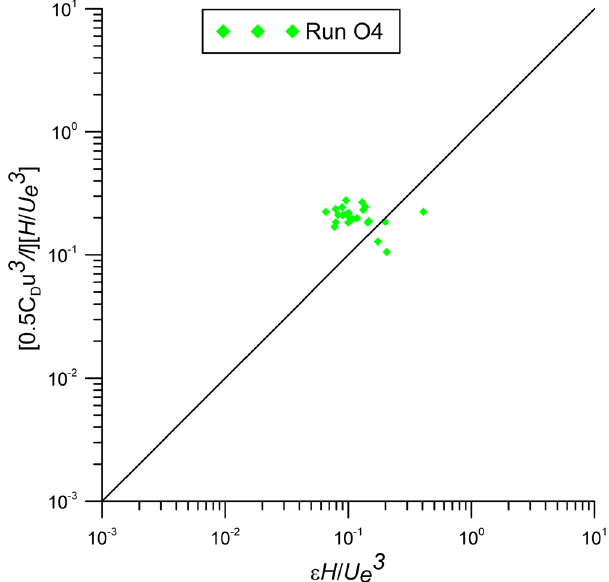
Figure 12. Estimates of dissipation rate of the cross section at x / D = 26.67 from the jet nozzle compared with the wake production in the zone of the interface of jets and channel